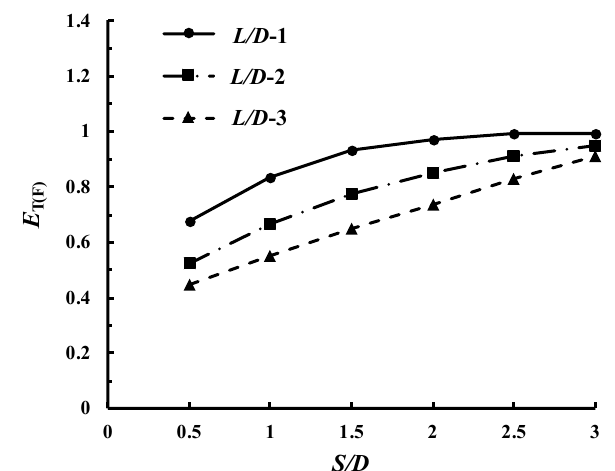
Figure 14. Torsional group efficiency with L / D and S / D ratios.